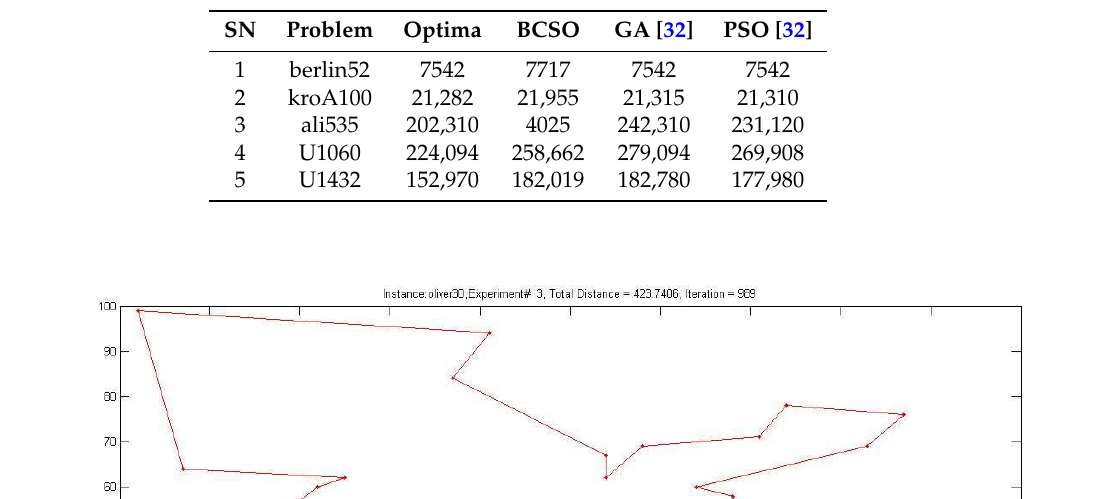
Table 10. Comparison results of the BCSO algorithm with GA and PSO [32] on some instances of TSP from the TSP library.